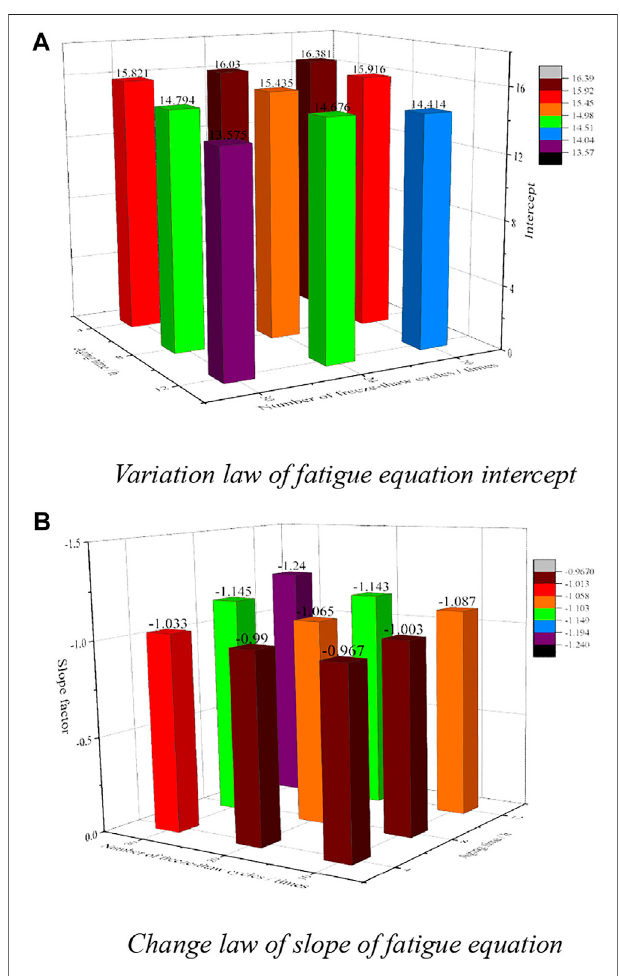
FIGURE 9 | Variation law of fatigue equation parameters. (A) Variation lawofthefatigueequationintercept. (B) Changelawoftheslopeofthefatigue equation.